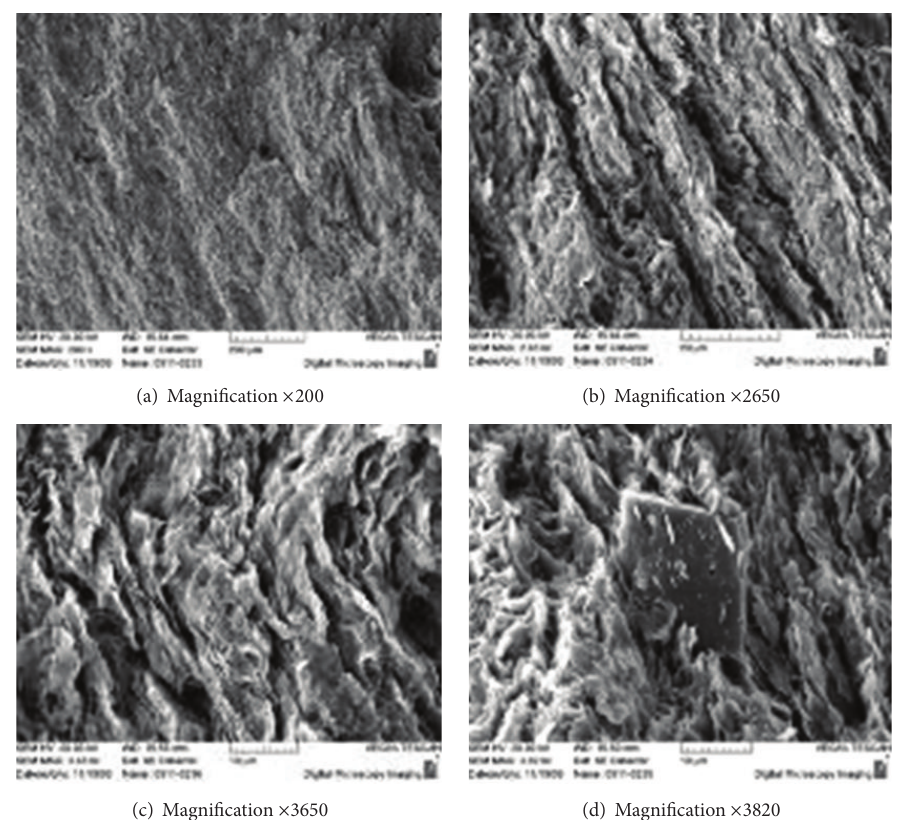
Figure 2: Scanned electron microscope images of the mudstone specimens extracted from the roof.